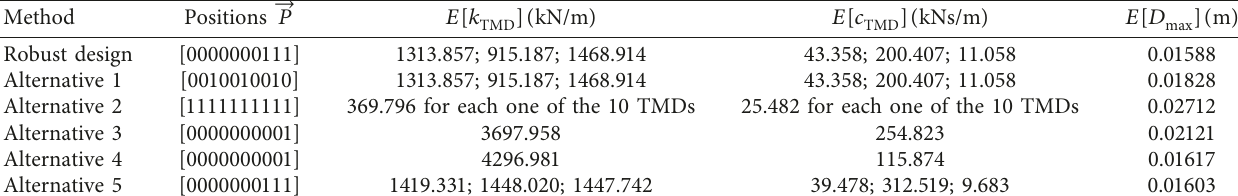
Table 4: Comparison between robust design and alternative methods.